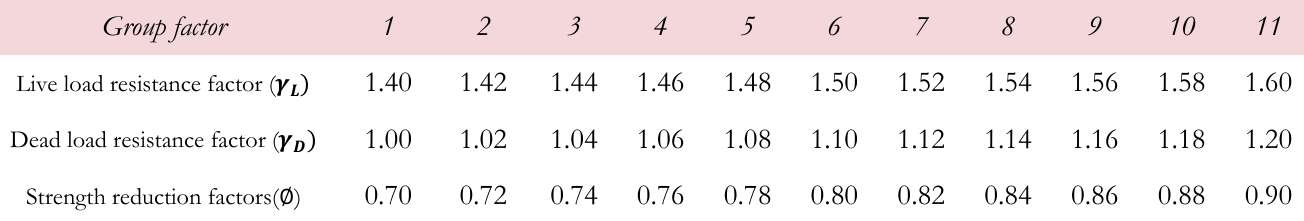
Table 3: Load and resistance factors for calculating the beta